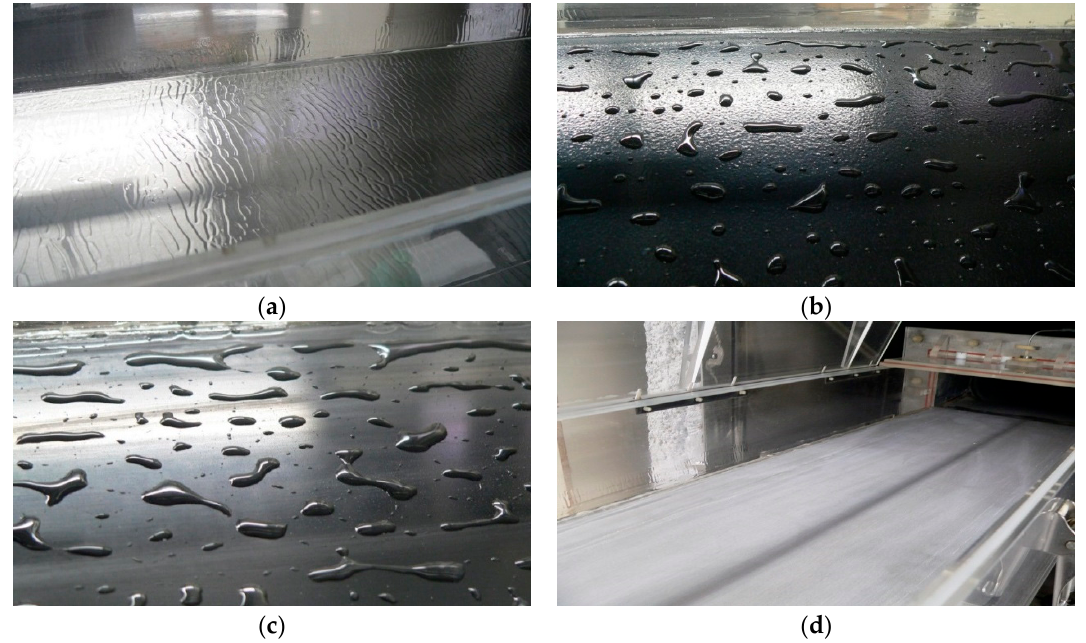
Figure 16. Ref. Fluid after a test run ( a ) on Aluminum ( b ) on Icephobic ( c ) on Hydrophobic ( d ) on Superhydrophobic 2.